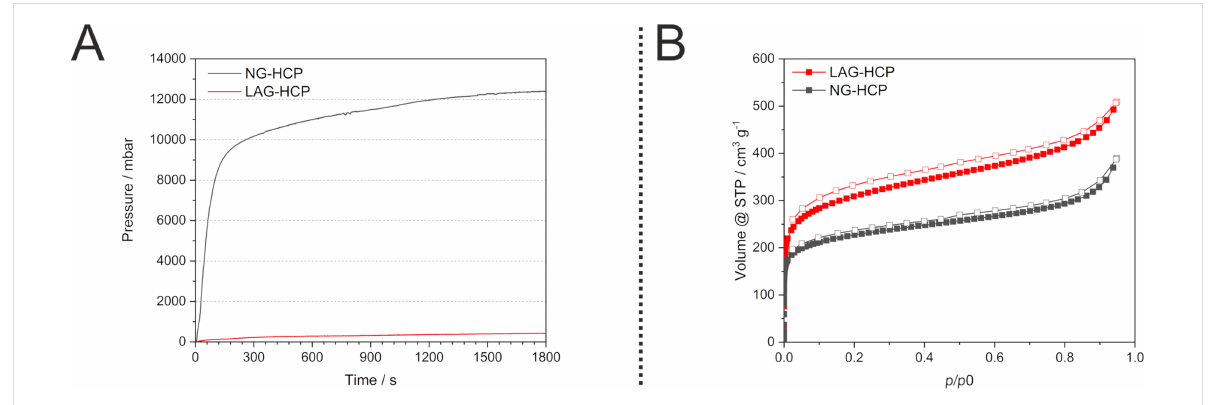
Figure 3: A: Evolution of pressure in the course of the reaction measured by the GTM system. The addition of 1 mL of Et 2 O is sufficient to drastically reduce the released pressure. B: Comparison of the low pressure nitrogen isotherm of NG-HCP and LAG-HCP.